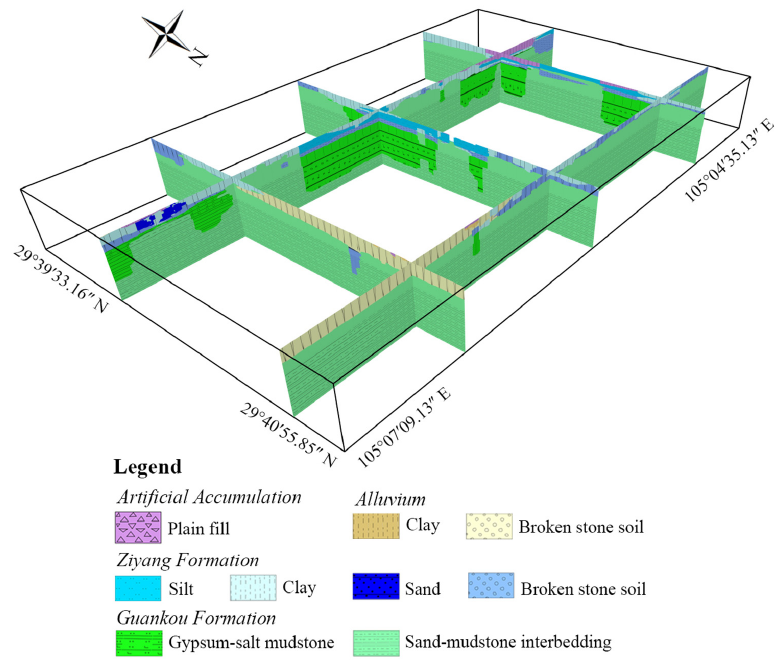
Figure 4. Cross-sections of the 3D geological model .